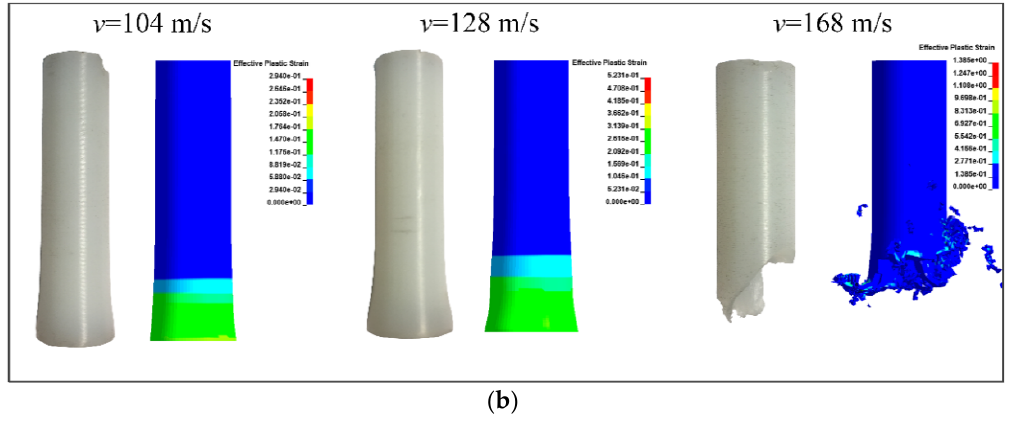
Figure 10. Comparison of 3D simulation results with tests: ( a ) amount of deformation ( b ) deformed shapes.